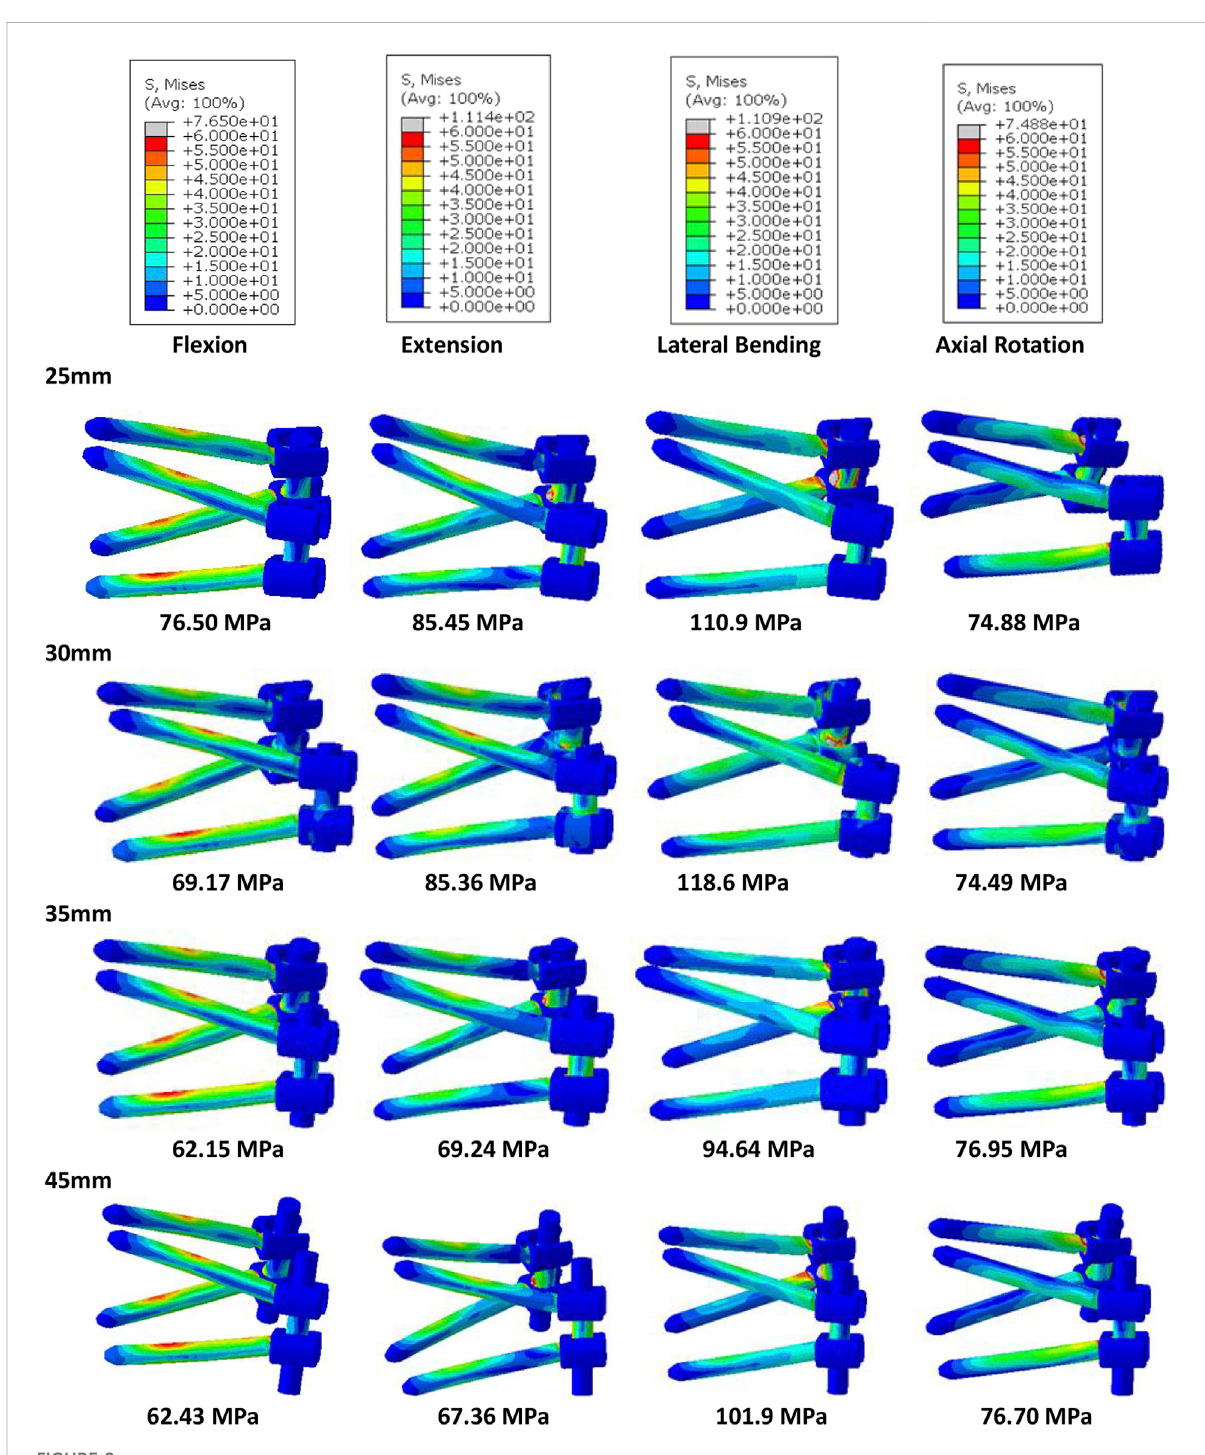
FIGURE 8 Von-Misesstressonthescrewsofthemodelsfordifferentrodlengthswhenplacedunder fl exion,extension,lateralbending,andaxialrotation, with the peak stress noted beneath each